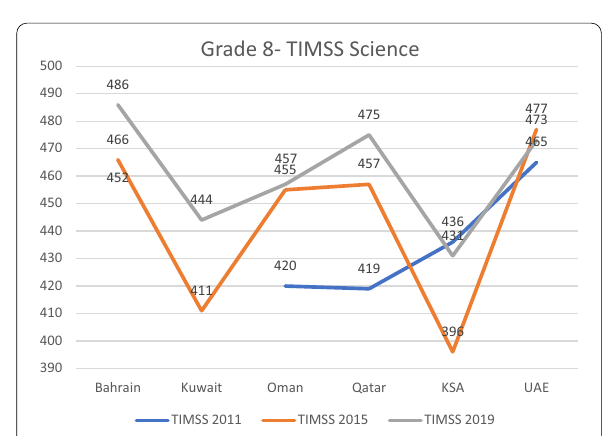
Fig. 4 Grade 8 TIMSS Science performance in